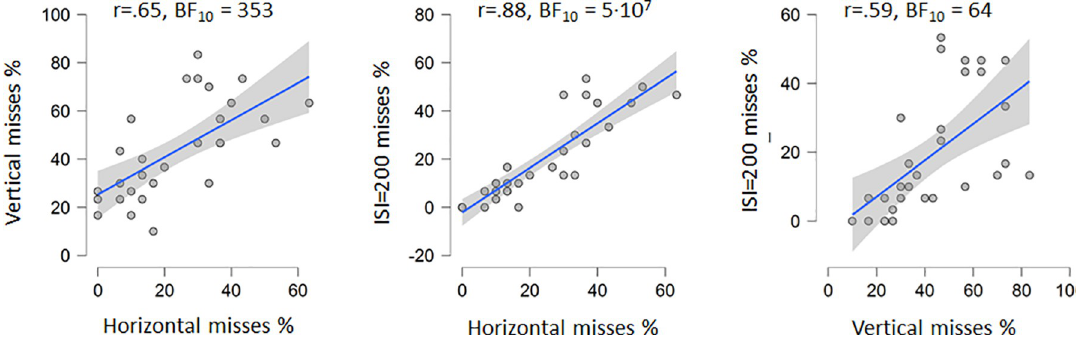
Fig 3. Scatterplots. The Pearson correlations analyses between total misses obtained in the horizontal, vertical, and the sequential condition with ISI = 200 milliseconds. Correlations, Bayes factors, regression lines and the 95% CI are shown. All p values < .001.